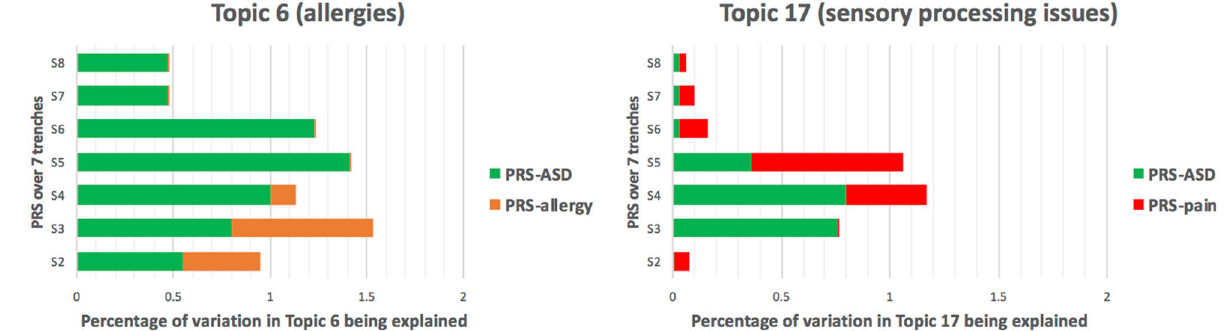
Figure 3. Relative contributions of polygenic risk scores (PRS) to the two topics of comorbid conditions. Relative contributions were calculated using the squared values from semi-parametric correlation tests. Topic 6 is over-represented by allergies while Topic 17 is over-represented by sensory processing issues. PRS ASD indicates the PRS values derived from the GWAS of ASD, PRS allergy indicates the PRS values derived from the GWAS of allergies, and PRS pain indicates the PRS values derived from the GWAS of chronic pain disorder.